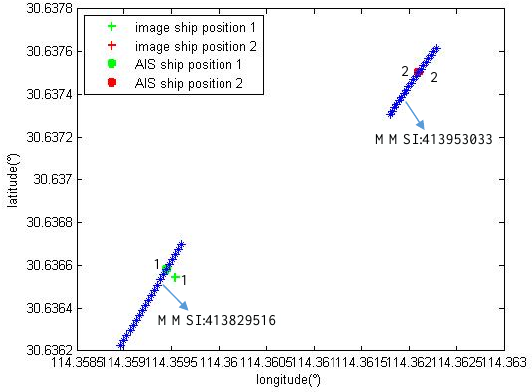
Sensors 2019 , 19 , x FOR PEER REVIEW Figure 12. The results of the point to track matching algorithm for the identification of two vessels.